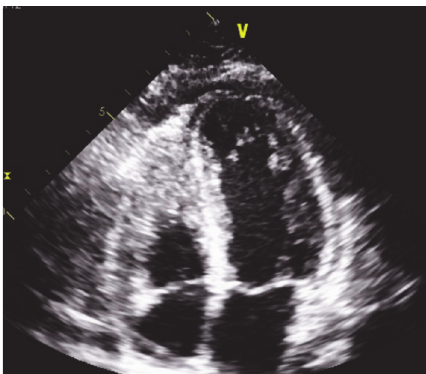
Figure 2: Chest X-ray on admission.